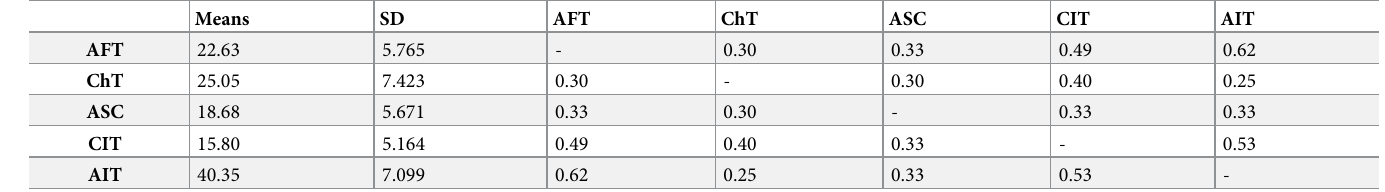
Table 4. TEAQ-37 Rus subscale data. Mean and standard deviations are provided for subscale score sums, and correlation coefficient values are given for correlations between the